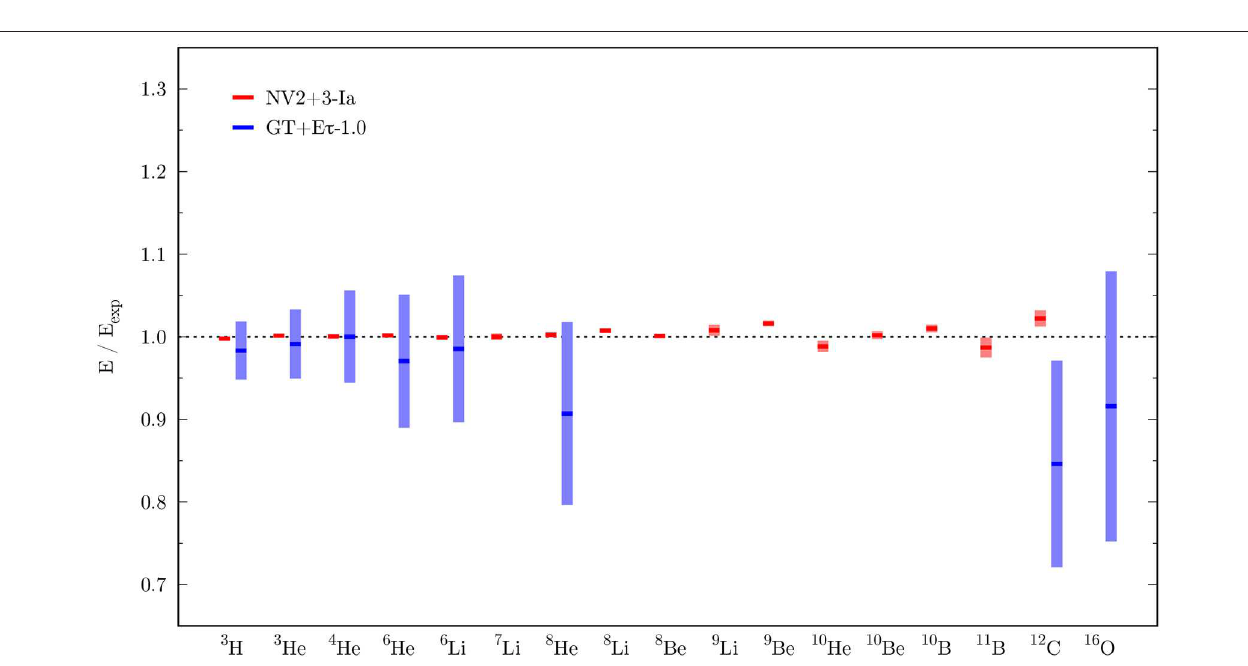
FIGURE 3 | Energy ratio between the calculated binding energies and the experimental data. The color scheme is the same as Figure 2